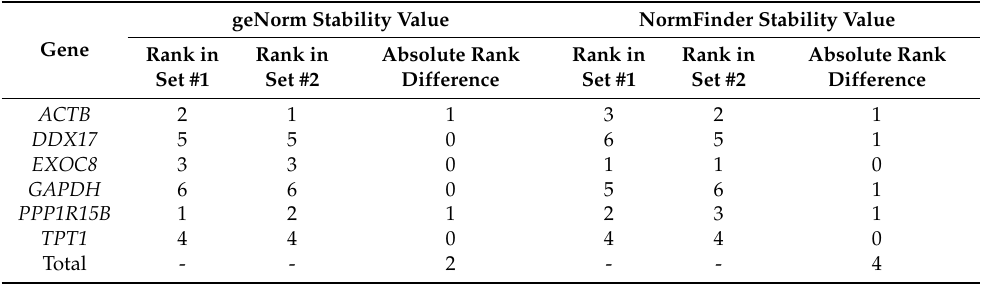
Table 4. Ranking of stability values calculated by the respective software in the two sets of samples. 1